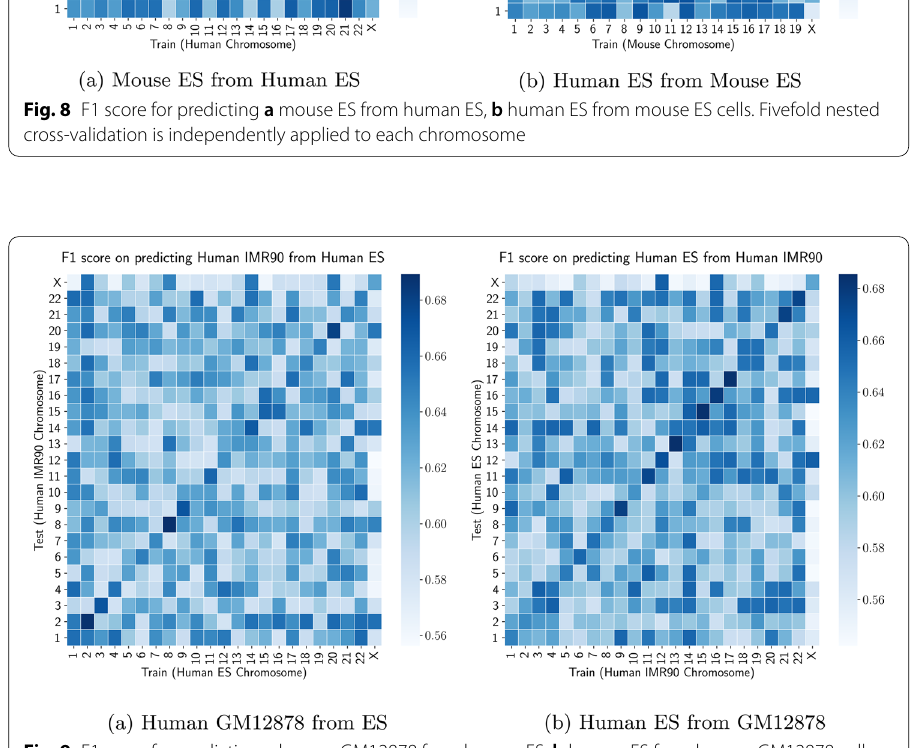
Fig. 9 F1 score for predicting a human GM12878 from human ES, b human ES from human GM12878 cells. 5-fold nested cross-validation is independently applied to each